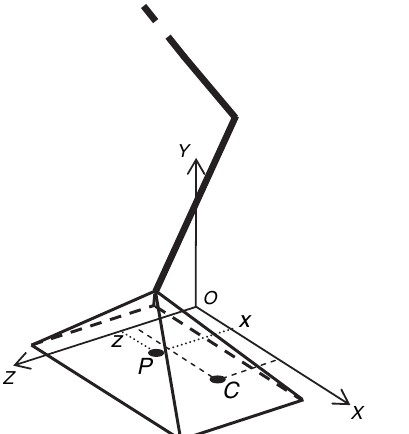
Figure 2 Scheme of the supporting foot illustrating the point P where δ P is calculated and the point C to show the ZMP